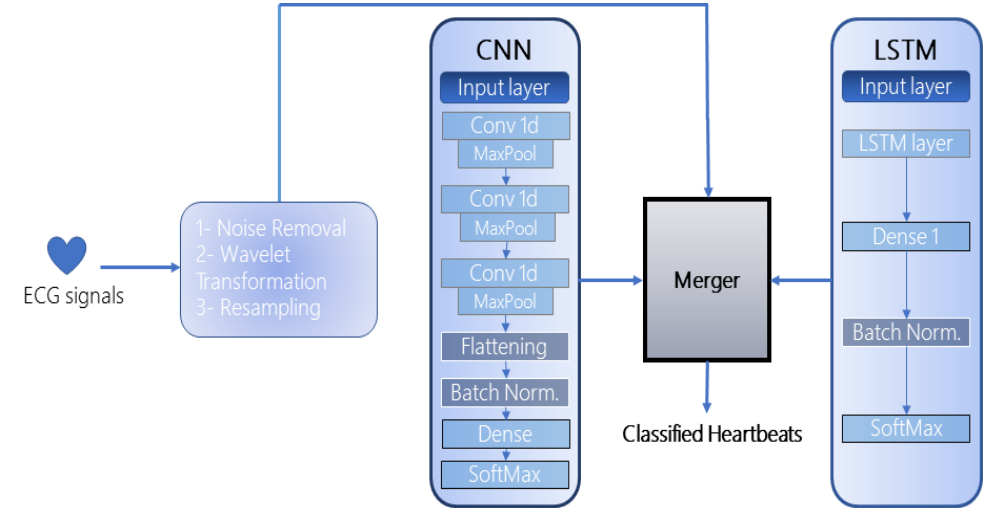
Figure 1. The Proposed